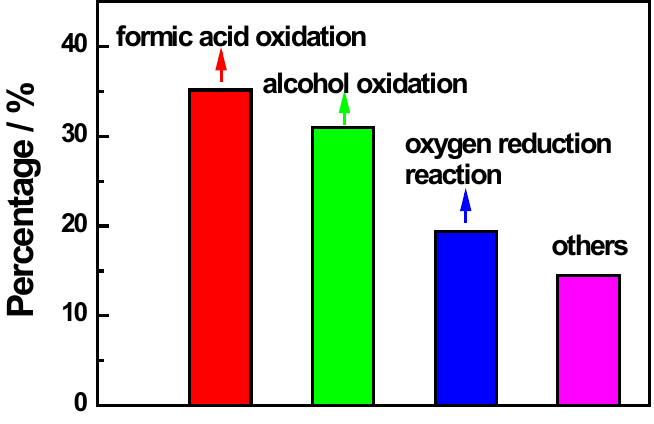
Figure 1. The distribution of Pd in recent four years in fuel cell